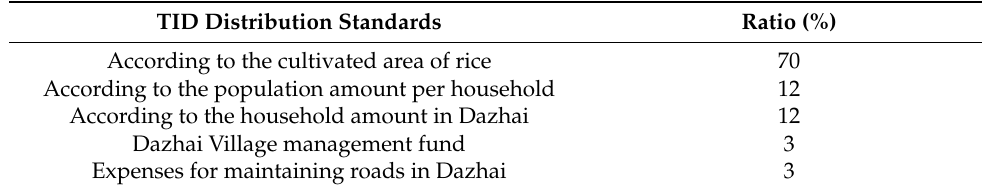
Table 5. The distribution scheme of